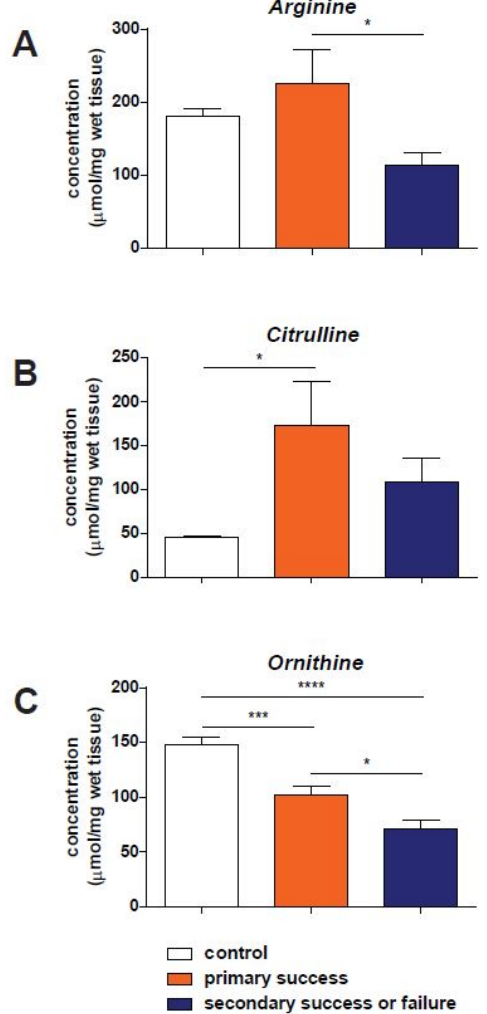
Figure 1. Concentrations of arginine (panel A ), citrulline ( B ) and ornithine ( C ) in reamed in- tramedullary aspirate, presented as µ mol/mg wet tissue. Results in control tissues are presented in the white bars. Samples obtained from patients with a primary successful RIA treatment are shown in orange and with an unsuccessful treatment in dark blue. *: p < 0.05; *** p < 0.001 and ****: p < 0.0001.